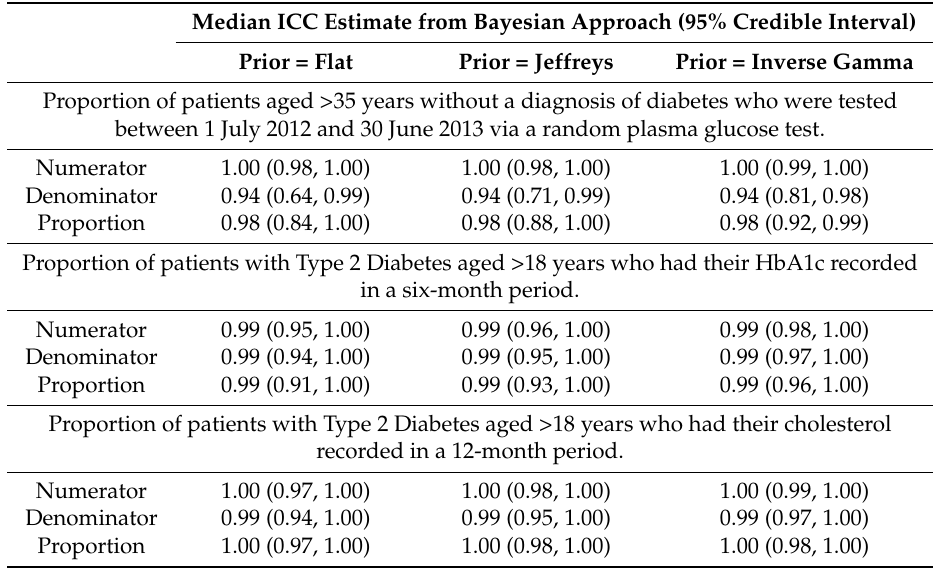
Table 2. Intra-Class correlation coefficients for each study